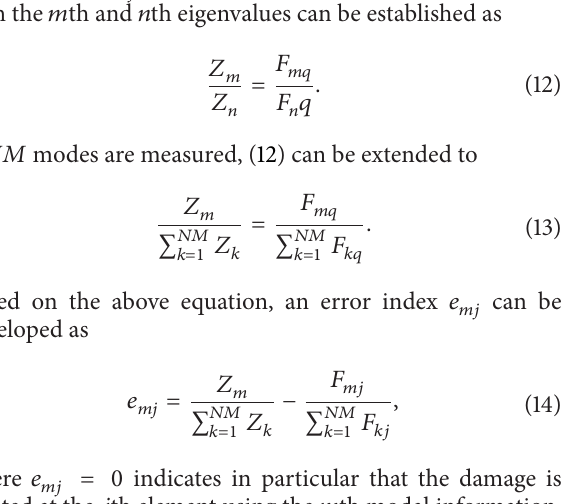
Figure 3: Vertical acceleration of the vehicle running on intact and damaged